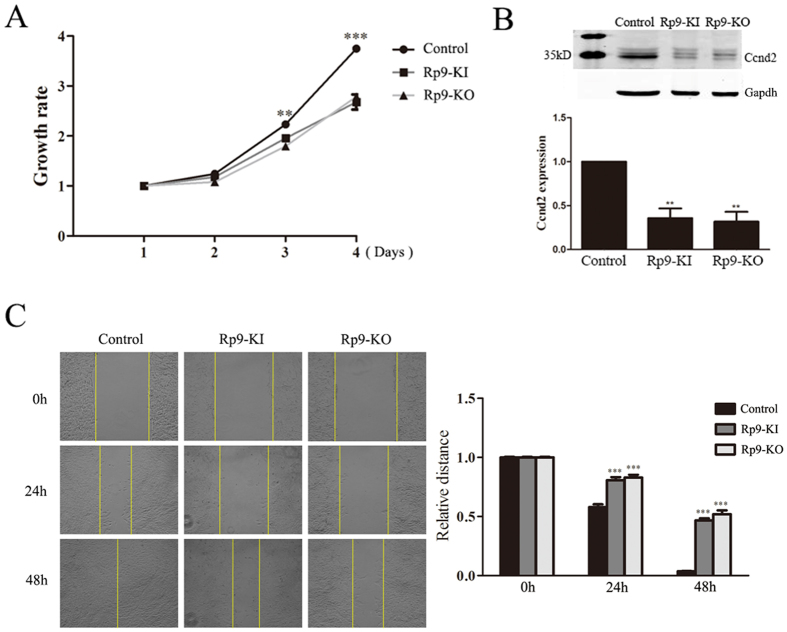
Rp9 gene mutation inhibited the proliferation and migration of 661 W cells.(A) MTT cell proliferation assay was performed at indicated days. Data at each time point were expressed as mean ± SEM based on results obtained from triplicates. **P < 0.01, ***P < 0.001. (B) Rp9 gene mutation down-regulated Ccnd2 expression. 661 W, Rp9-KI and Rp9-KO cell lysate were prepared and used for Western blot analysis. Gapdh was used as an internal loading control. The band intensity was measured with ImageJ software, the fold change was normalized to the level of 661 W group. Data are representative of three independent experiments. **P < 0.01. (C) In vitro scratch assays were performed to evaluate the migration potential of 661 W, Rp9-KI and Rp9-KO cells.